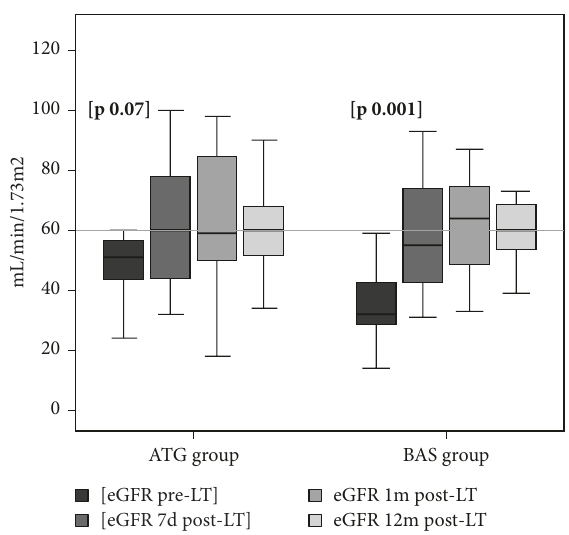
Figure 2: Glomerular filtration rate between groups at one year.